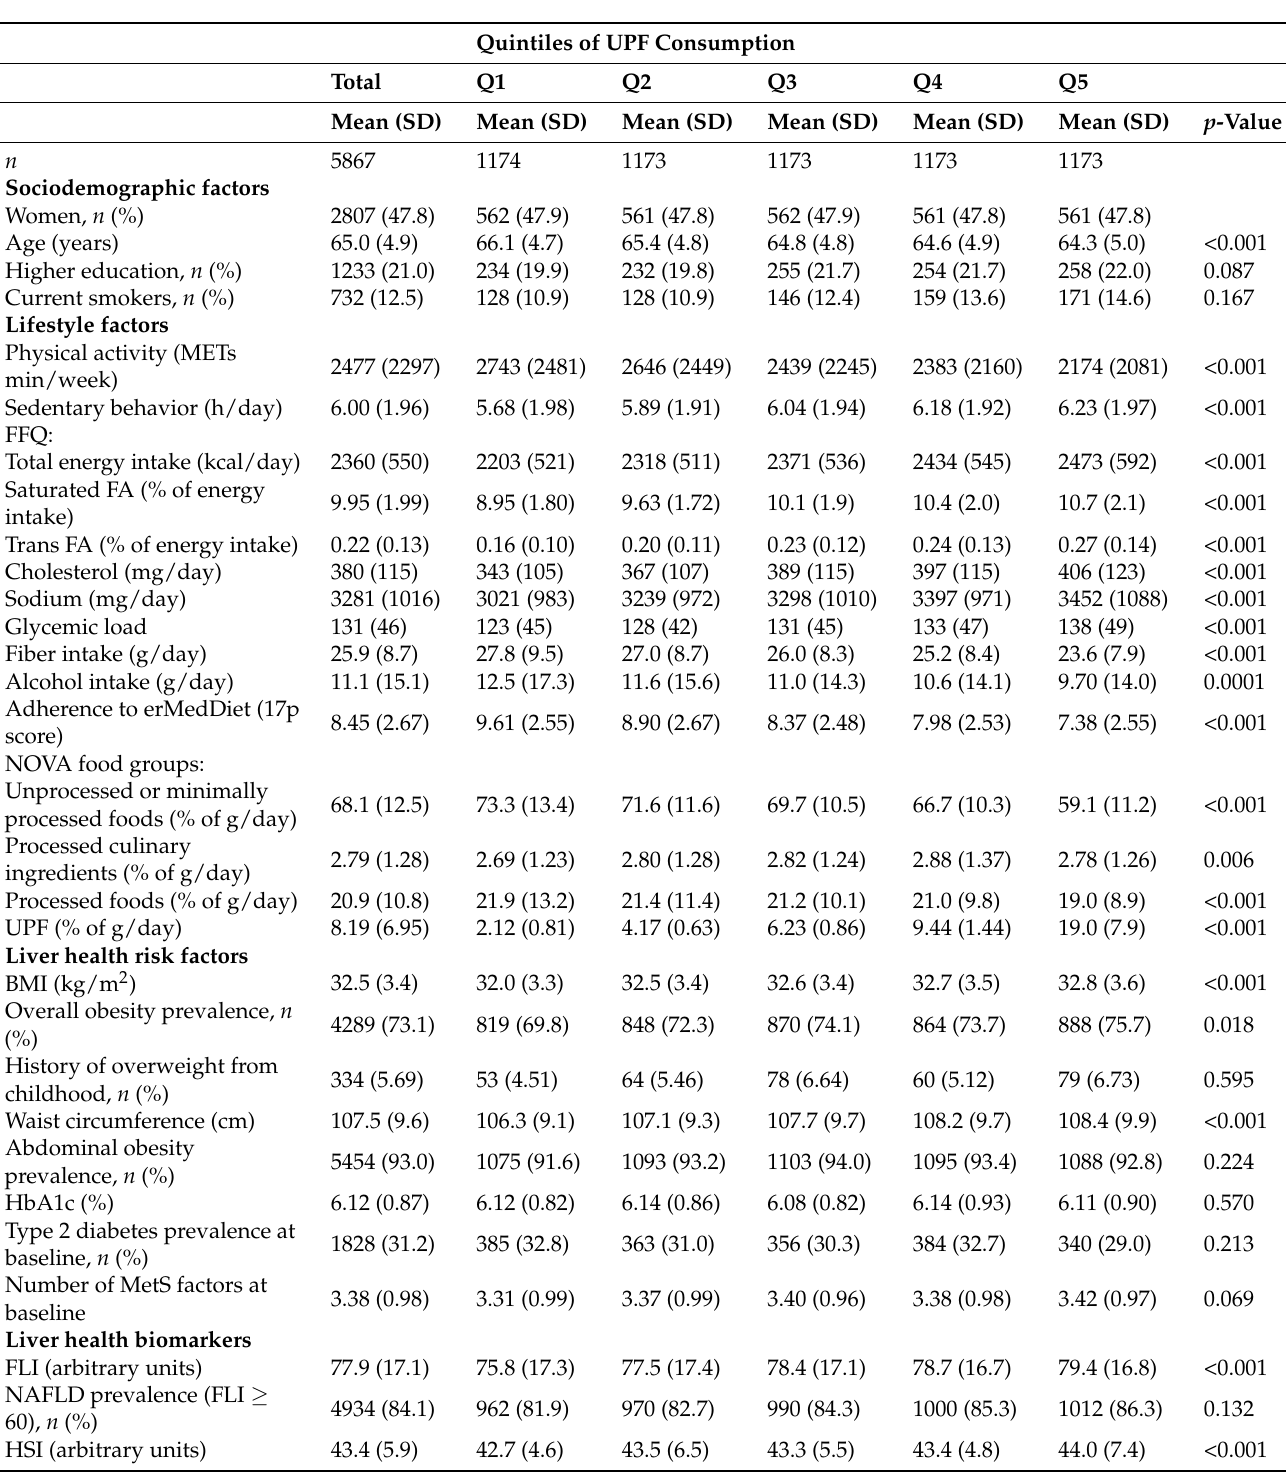
Table 2. Baseline characteristics of study participants according to baseline sex-specific quintiles of